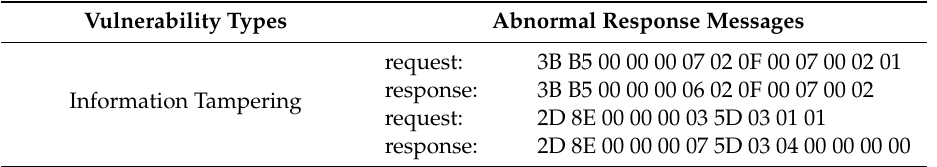
Table A2. All the abnormal response messages that cause the information tampering vulnerability.